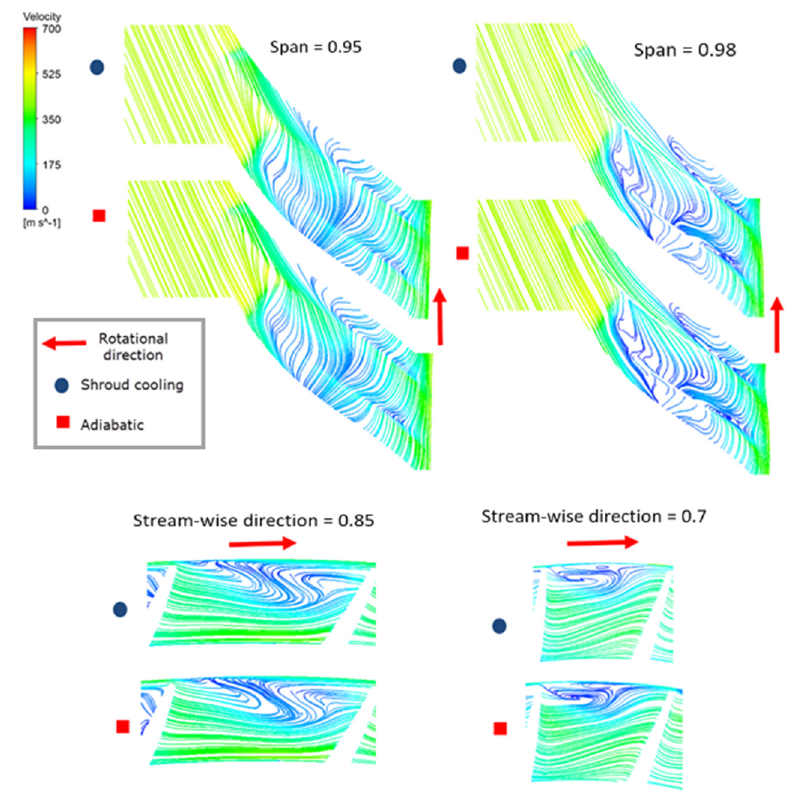
Figure 11 . Streamlines for the compressor in the adiabatic condition and with shroud cooling. Figure 11. Streamlines for the compressor in the adiabatic condition and with shroud